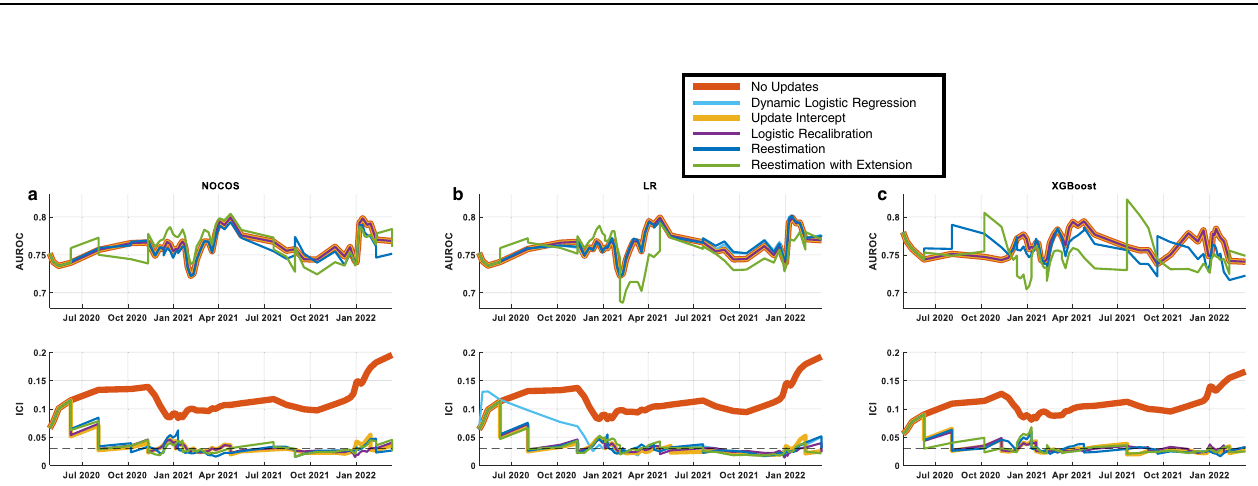
proportion of outcomes averaged over deciles of the predicted probabilities. The red histograms show the counts of patients that survived past 28 days binned by the predictedprobabilities. The green histogramsshow the counts of patients that died before28daysbinnedbythepredicted probabilities.Thediagonalblacklines indicate perfect calibration. The ICIs along with their 95% CIs are reported. ROC receiveroperatingcharacteristic,PRprecisionrecall,AUCareaundertheROCorPR curve, CI con fi dence interval, ICI integrated calibration index.